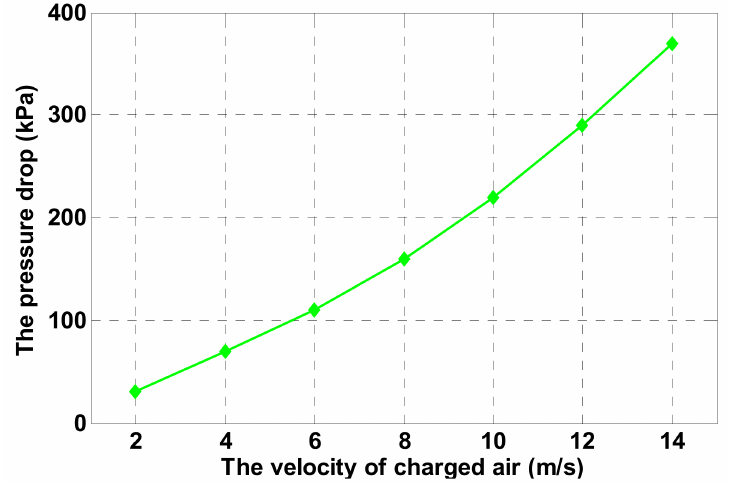
Figure 2. Curve of airside unit velocity pressure